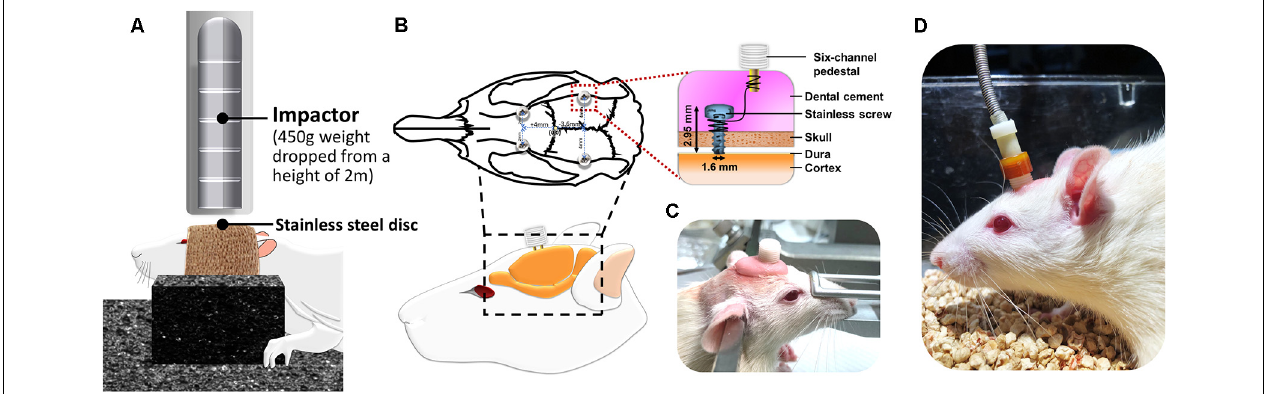
FIGURE 1 | Instrumentation setup of the traumatic brain injury (TBI) rat model and the placement and assembly of the cortical electrical stimulation (CES) electrode. (A) TBI rat model was induced using a 450-g brass weight falling from 2 m through a vertical transparent Plexiglas tube. (B,C) The CES electrodes were positioned at the frontal and parietal cortex and connected with wires in the six-channel pedestal and fixed with dental cement. (D) During CES treatment, the head electrode pedestal served as the plugin site of the electrode pin to conduct electrical current via the screw electrode on the cortex.